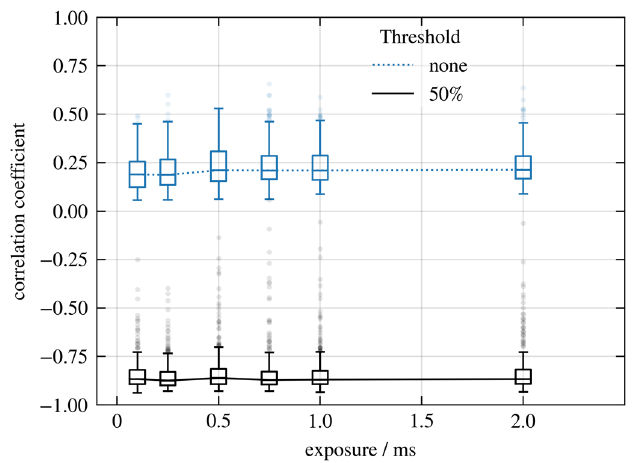
Figure 15. Normalized correlation coefficients between the OH* and soot distributions in a turbulent ethylene/air diffusion flame (compare Figure 14) without filtering (blue, dotted) and by limiting the correlation to the most intense features (black, solid).